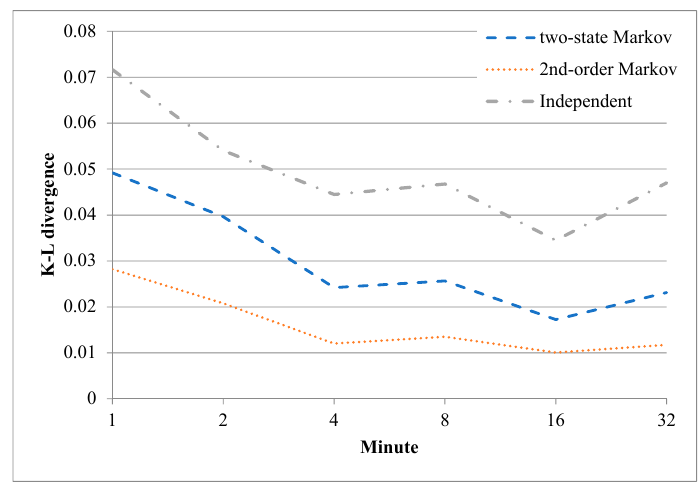
Figure 15. Kullback-Leibler (K-L) divergence between correct-frame bursts of original records and those of synthetic data. Sensors 2020 , 20 , x FOR PEER REVIEW